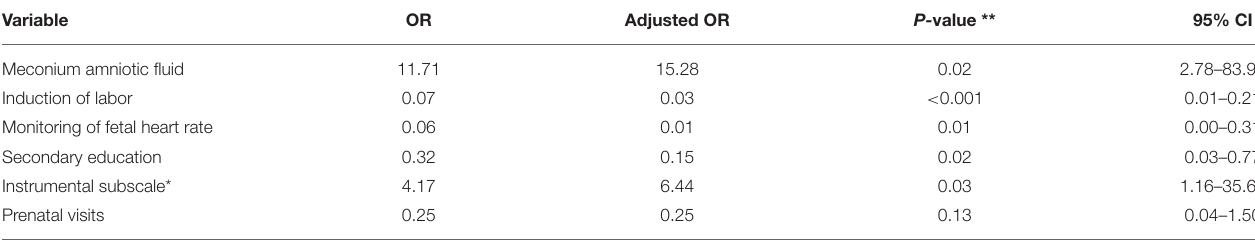
TABLE 5 | Multivariate